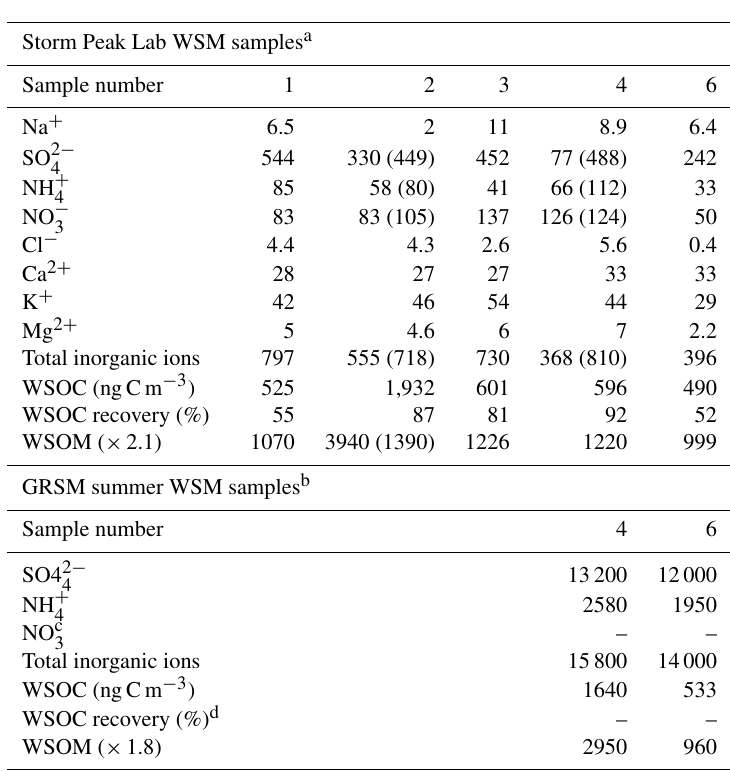
Table 2. Concentration (ngm − 3 ) of inorganic ions, organic carbon, and organic mass in WSM